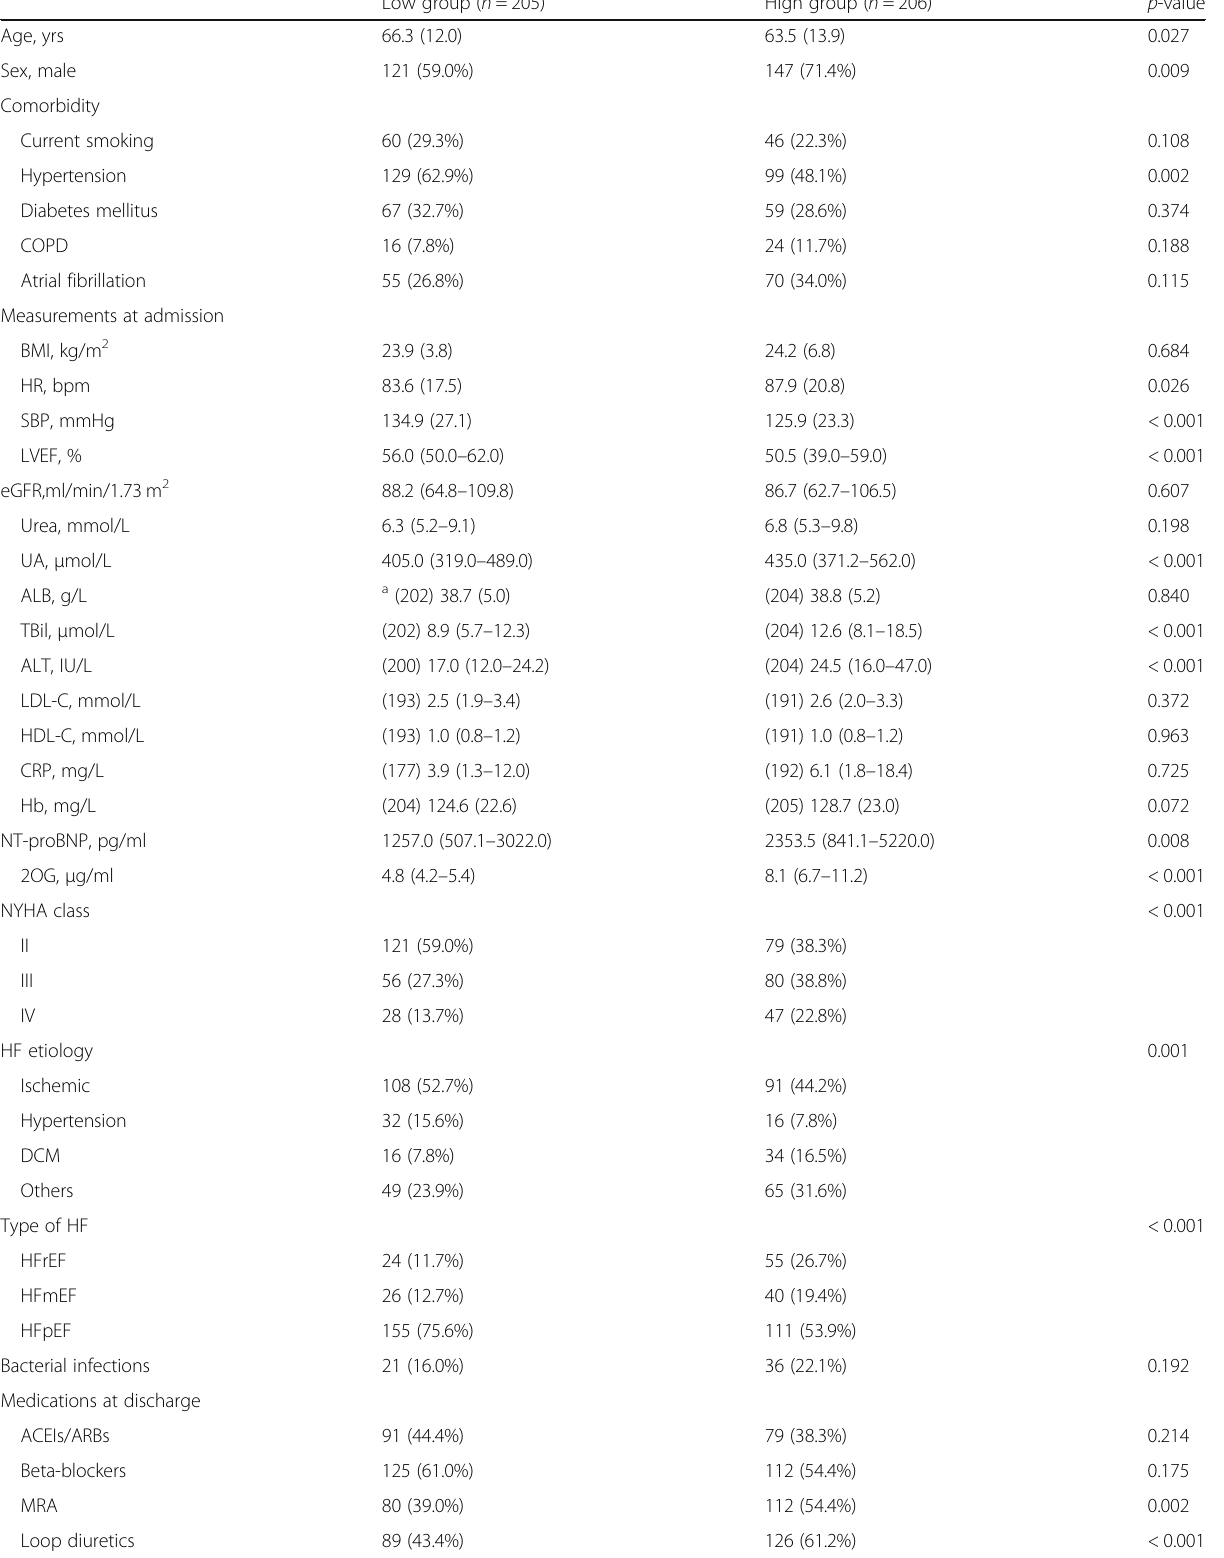
Table 1 Baseline characteristics of the AHF cohort ( n =